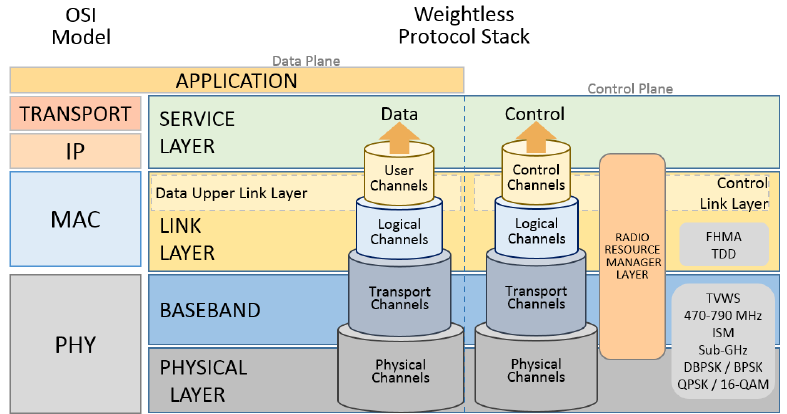
Figure 14. Weightless protocol